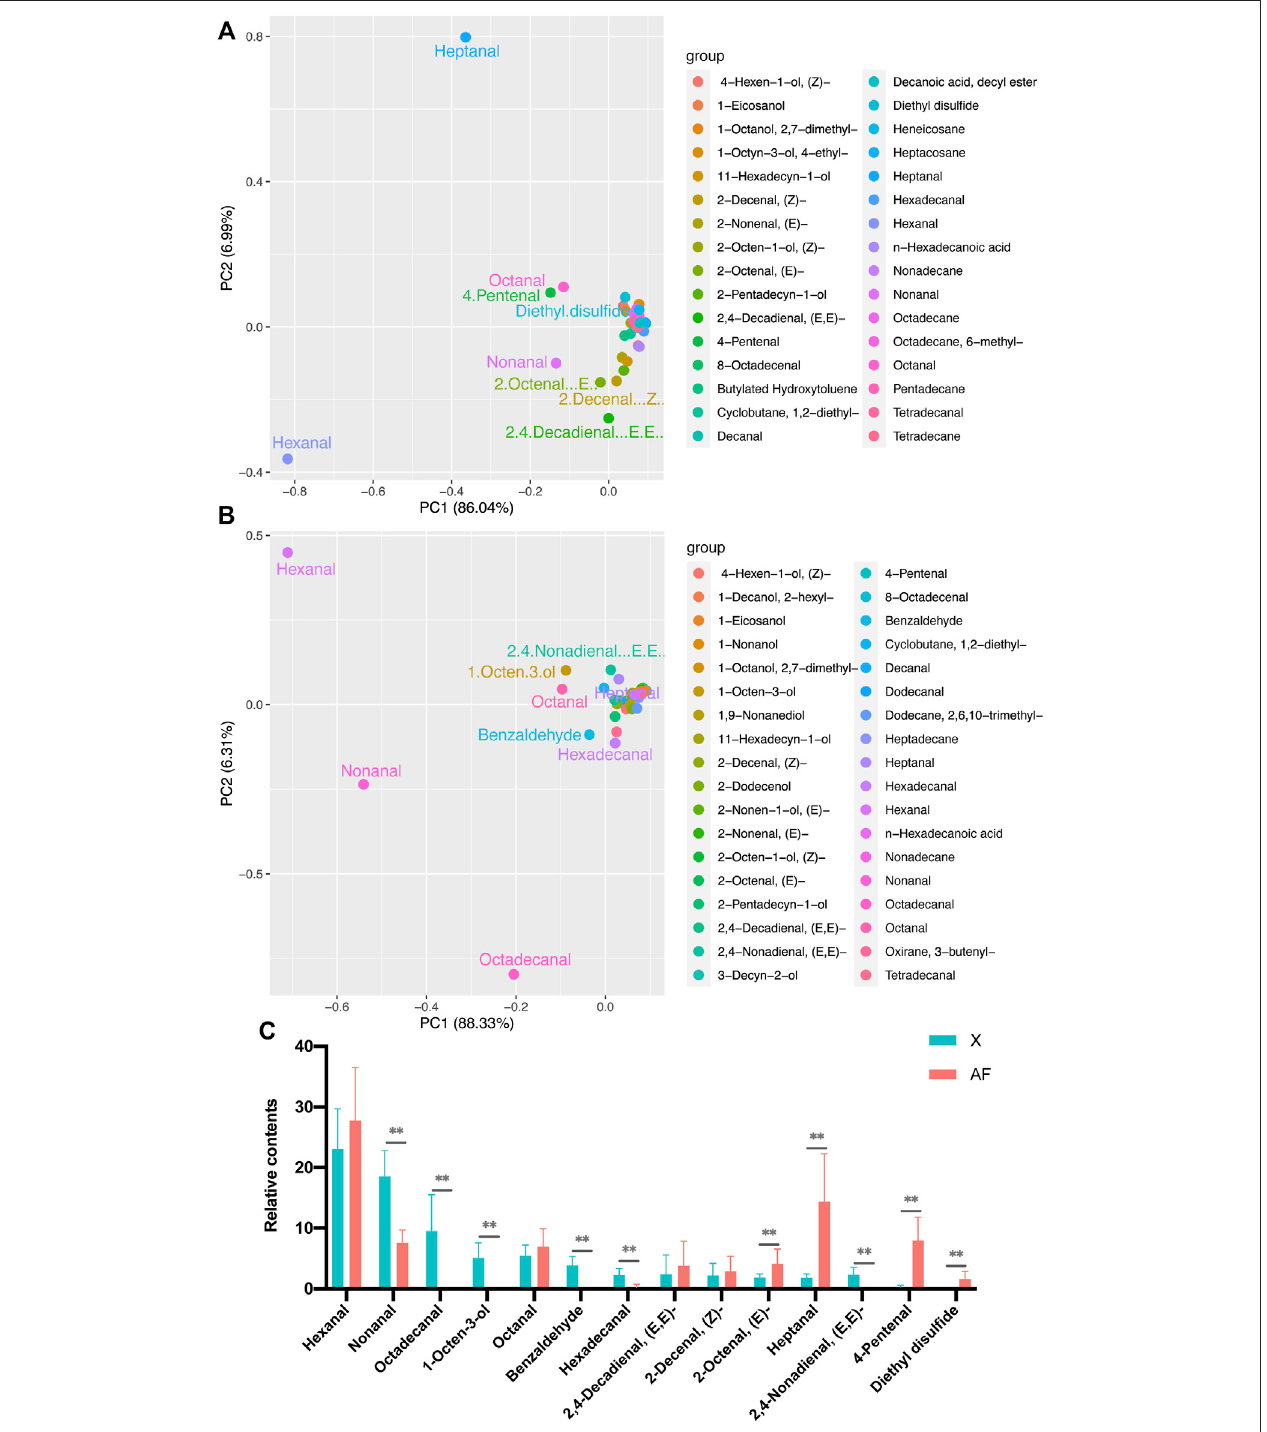
FIGURE 2 | (A) PCA results of major volatile compounds in BM tissue. (B) PCA results for major volatile compounds in AF tissue. (C) Levels of major volatile compounds.